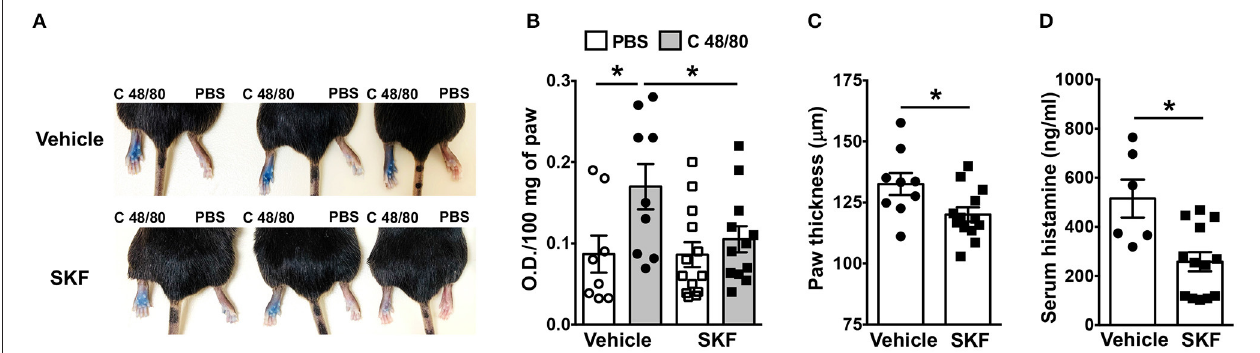
FIGURE 7 | SOCE Inhibition reduces paw edema to compound 48/80. PBS (vehicle) or SKF-treated C57BL/6 mice were exposed to compound 48/80, (C 48/80, left paw) or PBS (right paw) and Evans blue dye was injected i.v. Mice were culled 30min later. (A) Representative pictures of three mice for each group with dye leakage in the paws are shown. (B) The paws were excised and weighed; the dye was extracted and absorbance of the supernatant was measured at 650nm. (C,D) Bar graphs shows the paw thickness (C) and histamine levels in serum (D) of mice. Data shown are mean ± S.E. from three experiments ( n = 6–13 mice/group). Statistical significance was determined by Student’s t -test. * p <